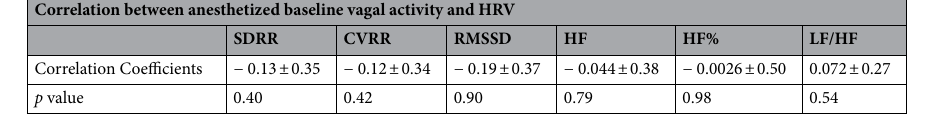
Table 1. Correlations of anesthetized baseline vagal activity with HRV. Data shown are the averages for six animals (63 total recordings). None of the six HRV metrics have correlations significantly different from zero (Bonferroni corrected significant level of p = 0.0083). Supplemental Table 1 shows individual correlations and p values for each animal.